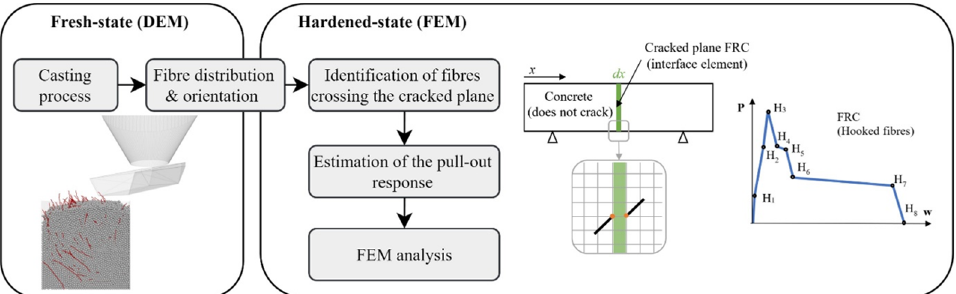
Figure 1 . Holistic modelling strategy to assess the behaviour of